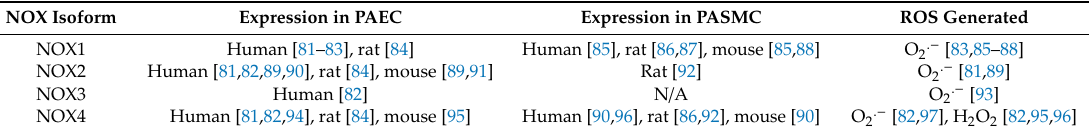
Table 1. Expression of NOX isoforms in the pulmonary vasculature.